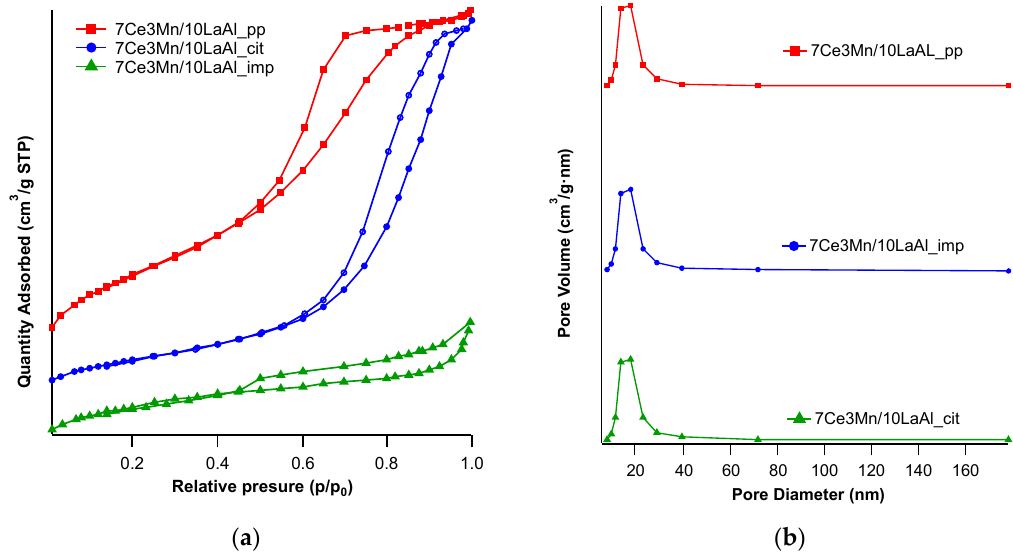
Figure 3. Textural characterization data for lanthanum-modified alumina supported cerium–manganese mixed oxides samples: ( a ) adsorption-desorption isotherms; ( b ) pore size